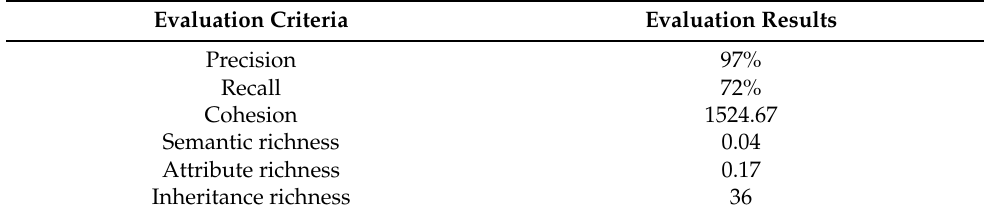
Table 2. Online retail evolved ontology evaluation.